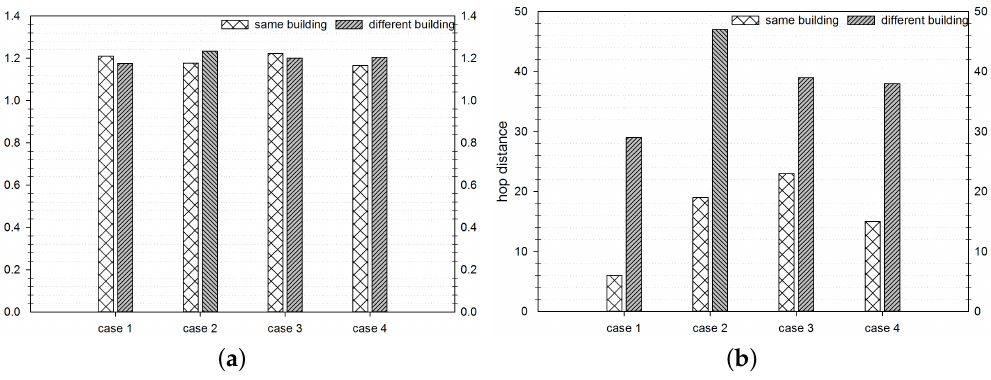
Figure 17. Performance of the path between two cells in four cases in regular density environments. ( a ) Response time performance; ( b ) the distance of hops in the same and different buildings.